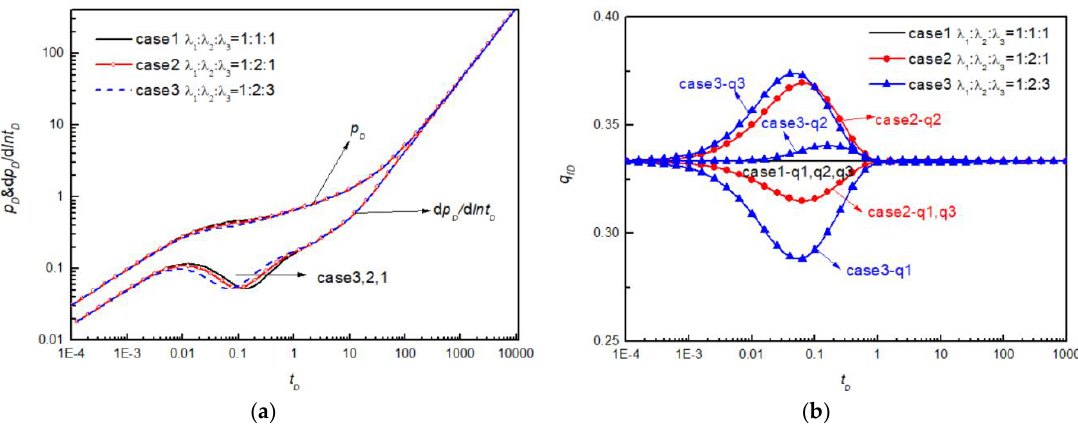
Figure 8. Pressure response and flux distribution of different crossflow ratio. ( a ) Pressure and pressure derivative; ( b ) Flux distribution of each hydraulic fracture.